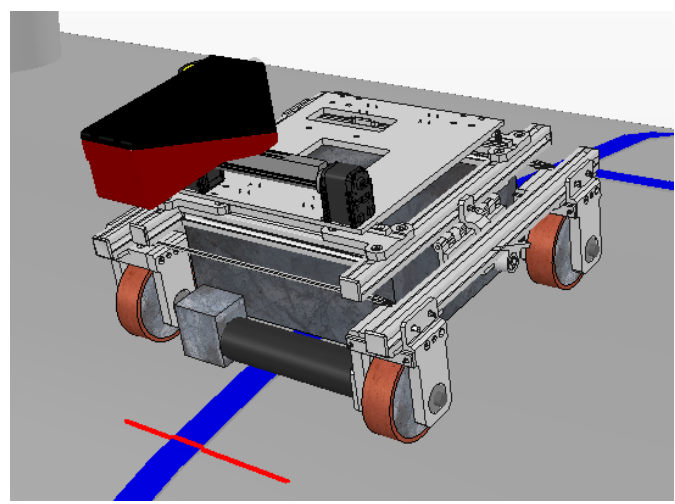
Figure 16. Autonomous Inspection Robot 1 (AIR-1) in the V-REP simulator.